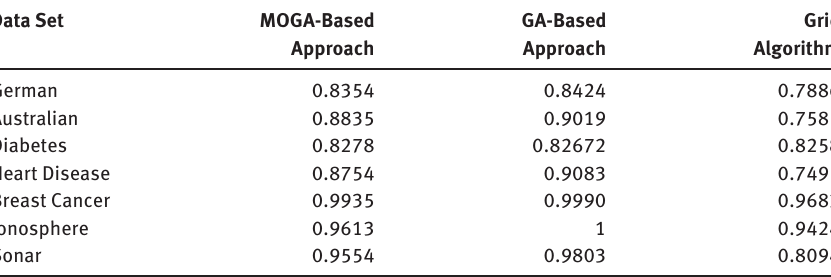
Table 8. Average AUC for Two-Class Data